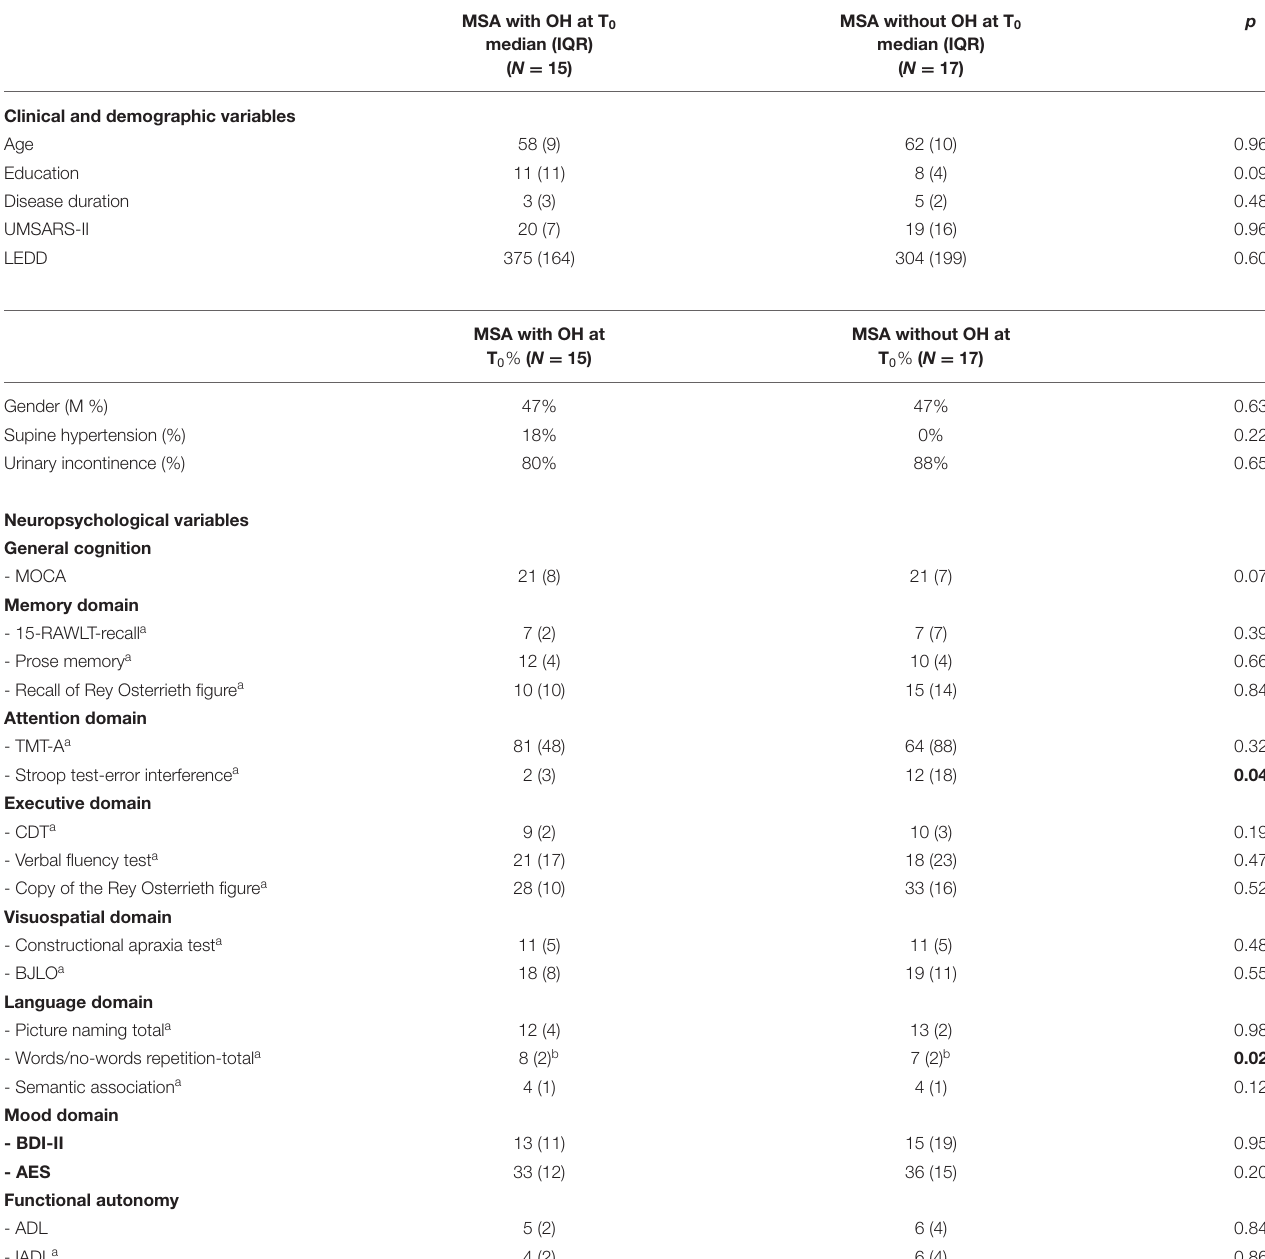
TABLE 1 | Clinical, demographic, and neuropsychological features in MSA patient with and without OH at baseline.